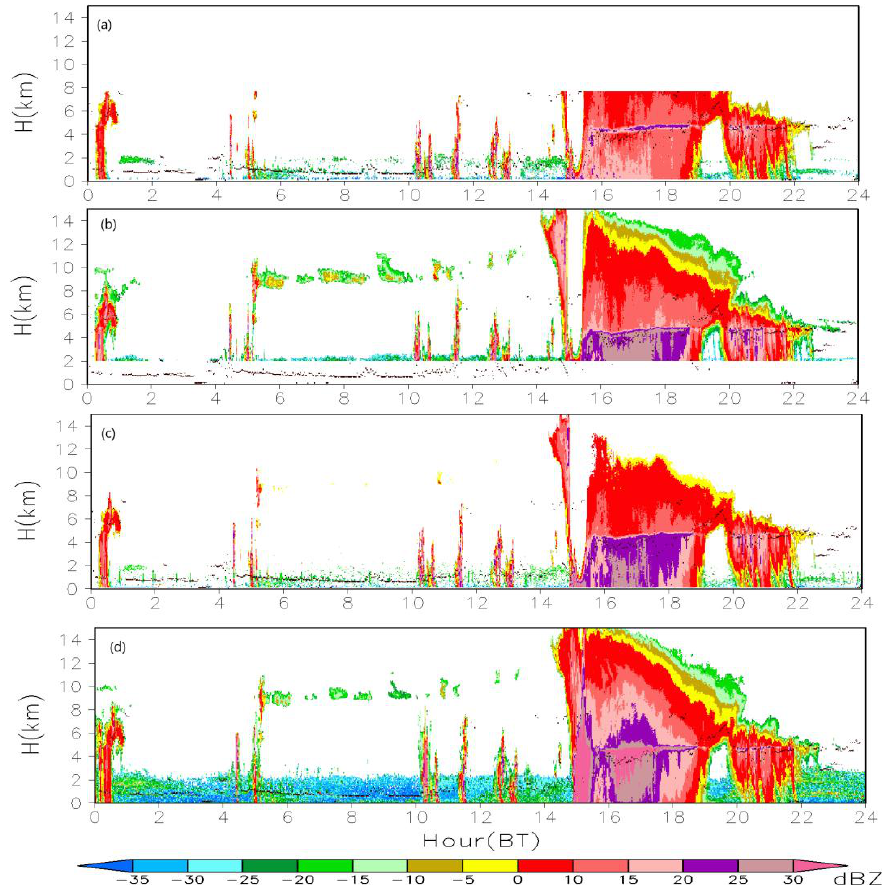
Figure 3. The time-height cross-sections of reflectivity on 4 June 2016 from: ( a ) CR1; ( b ) CR2; ( c ) CR3 and ( d ) CVPR. The block dots are the CEIL-derived cloud-base heights.